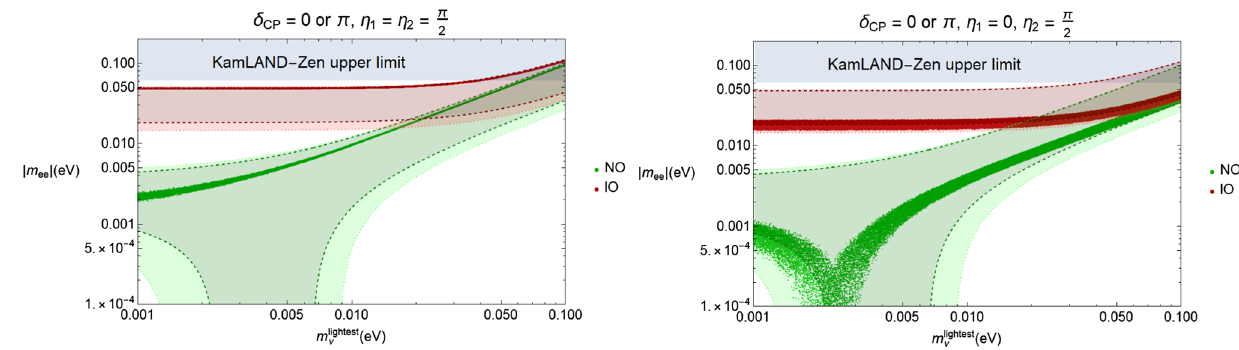
Fig. 3 0 ν 2 β prediction for the effective Majorana mass as a function of the lightest neutrino mass, considering two sets of Majorana phases: η = π/ 2 = η η = 0 ,η = π/ 2 (right). In green is shown NO, while IO appears in 1 2 (left) and 1 2